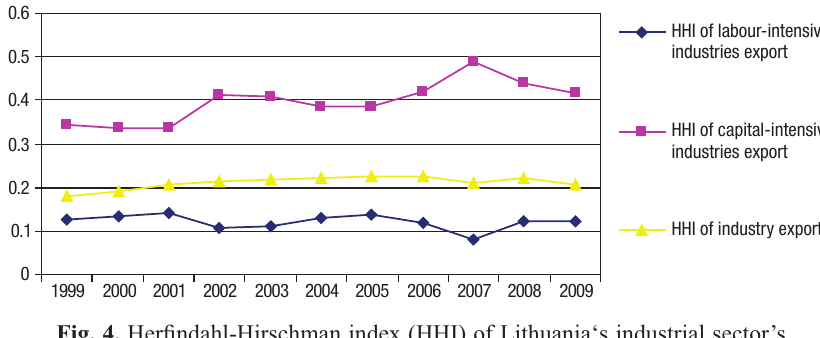
Fig. 4. Herfi ndahl-Hirschman index (HHI) of Lithuania‘s industrial sector’s export during 1999–2009 (Division of industries into labour-intensive and capital-intensive is presented below, in Table